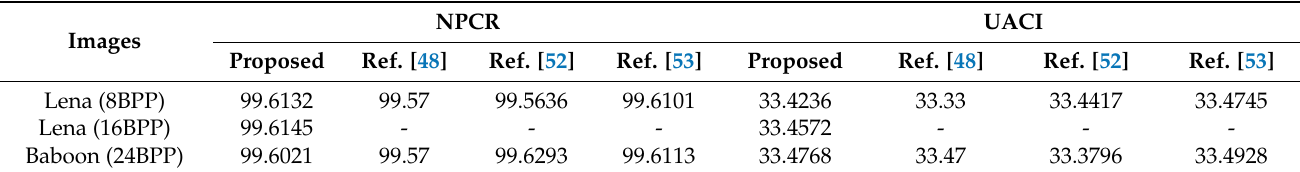
Figure 14. Cipher images and decrypted images of plain images with one-pixel difference: ( a1 ) Lena (8BPP); ( a2 ) Cipher image of ( a1 ); ( a3 ) Cipher image of ( a1 ) changed by one pixel; ( a4 ) Decryption of ( a2 ); ( a5 ) Decryption of ( a3 ); ( b1 ) Lena (16BPP); ( b2 ) Cipher image of ( b1 ); ( b3 ) Cipher image of ( b1 ) changed by one pixel; ( b4 ) Decryption of ( b2 ); ( b5 ) Decryption of ( b3 ); ( c1 ) Baboon; ( c2 ) Cipher image of ( c1 ); ( c3 ) Cipher image of ( c1 ) changed by one pixel; ( c4 ) Decryption of ( c2 ); ( c5 ) Decryption of ( c3 ). Table 15. NPCR and UACI values of the cipher images (%).